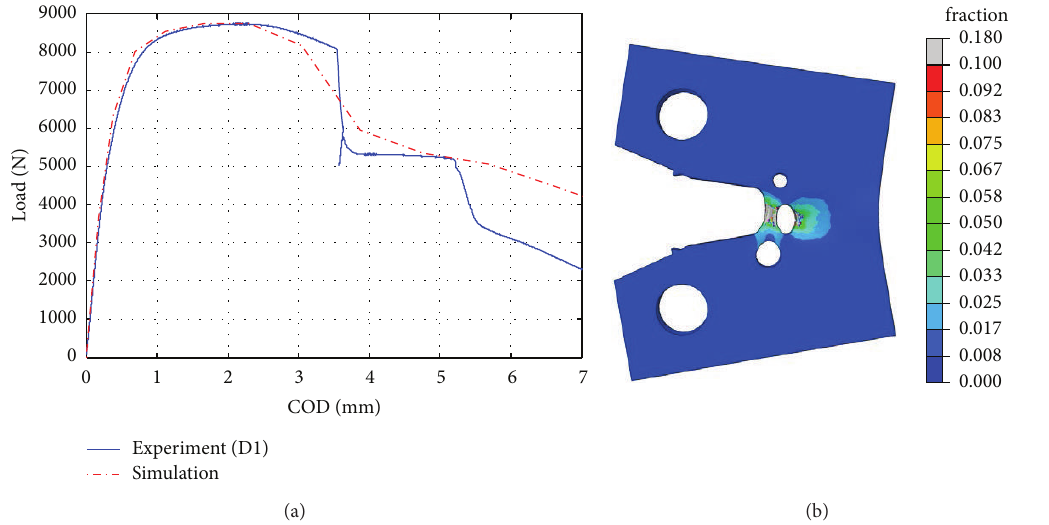
Figure 4: Experimental load versus COD profiles for D1 specimen and simulated load verus COD profile for nominal specimen, (a). The contour of void volume fraction, showing void accumulation along ligament A-C, taken at load = 4,471 N, (b).